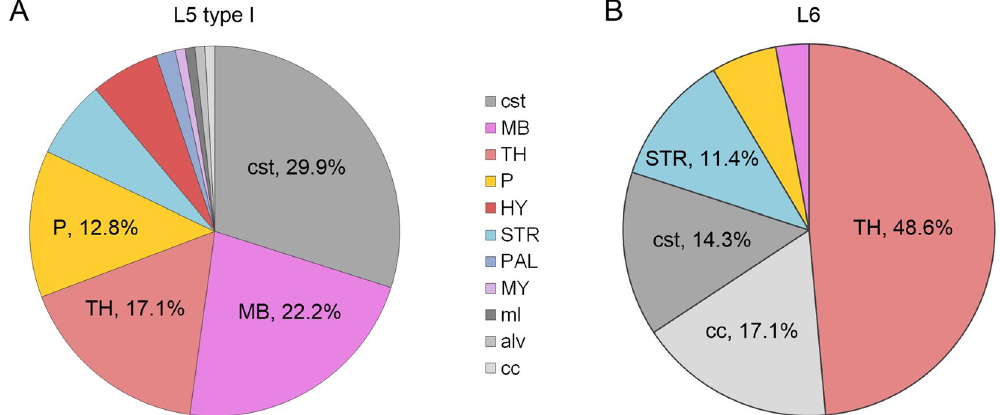
Figure 3. Pie charts on the fractional occurrence frequency of a certain projection target region to all regions observed by the axon tip. Results of L5 type I neurons ( A ) and L6 neurons ( B ). The frequency values ranked in descending order in a clockwise direction. Abbreviations: cst – corticospinal tract; MB – Midbrain; TH –Thalamus; P – Pons; HY – Hypothalamus; STR – Striatum; PAL – Pallidum; MY – Medulla; ml – medial lemniscus; alv – alveus; cc – corpus